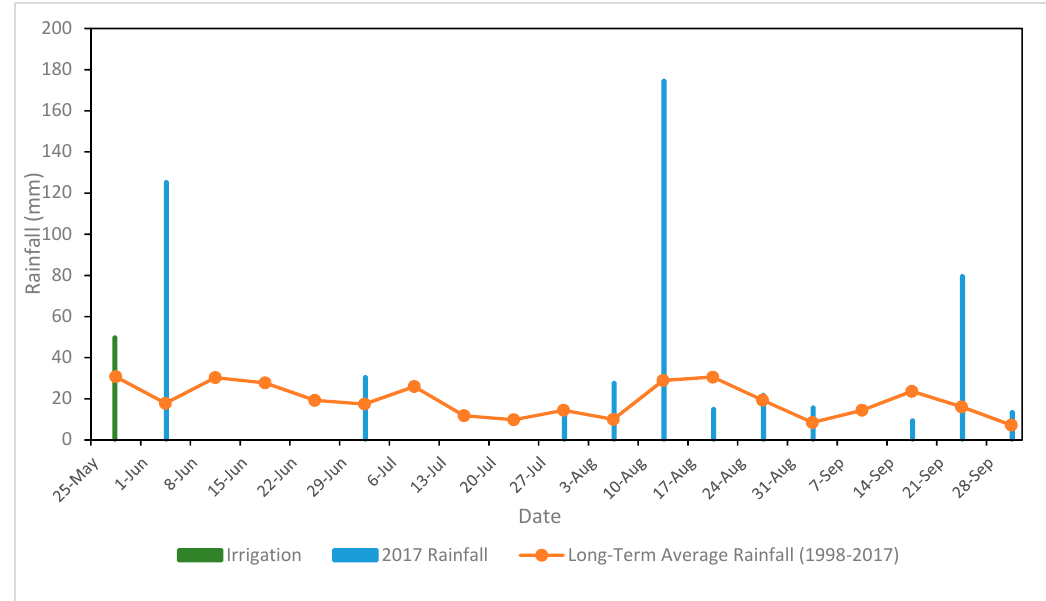
Figure 1. Weekly irrigation and rainfall received during the summer growing season of 2017 and the long-term trend in the average rainfall (1998–2017) at El Reno, OK.